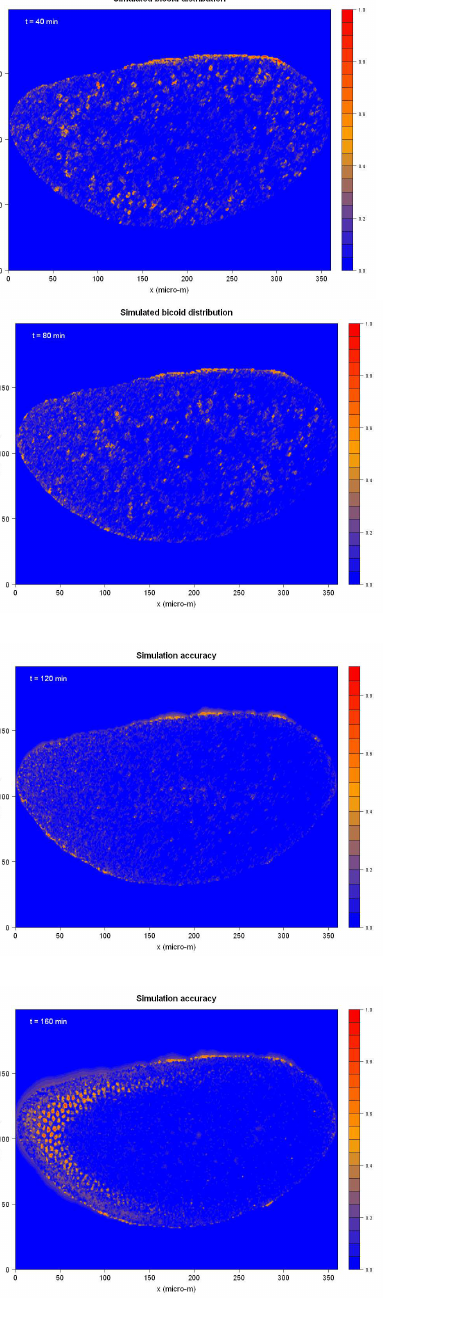
Figure 9: Euclidean distance between experimental frames and Redi simulated